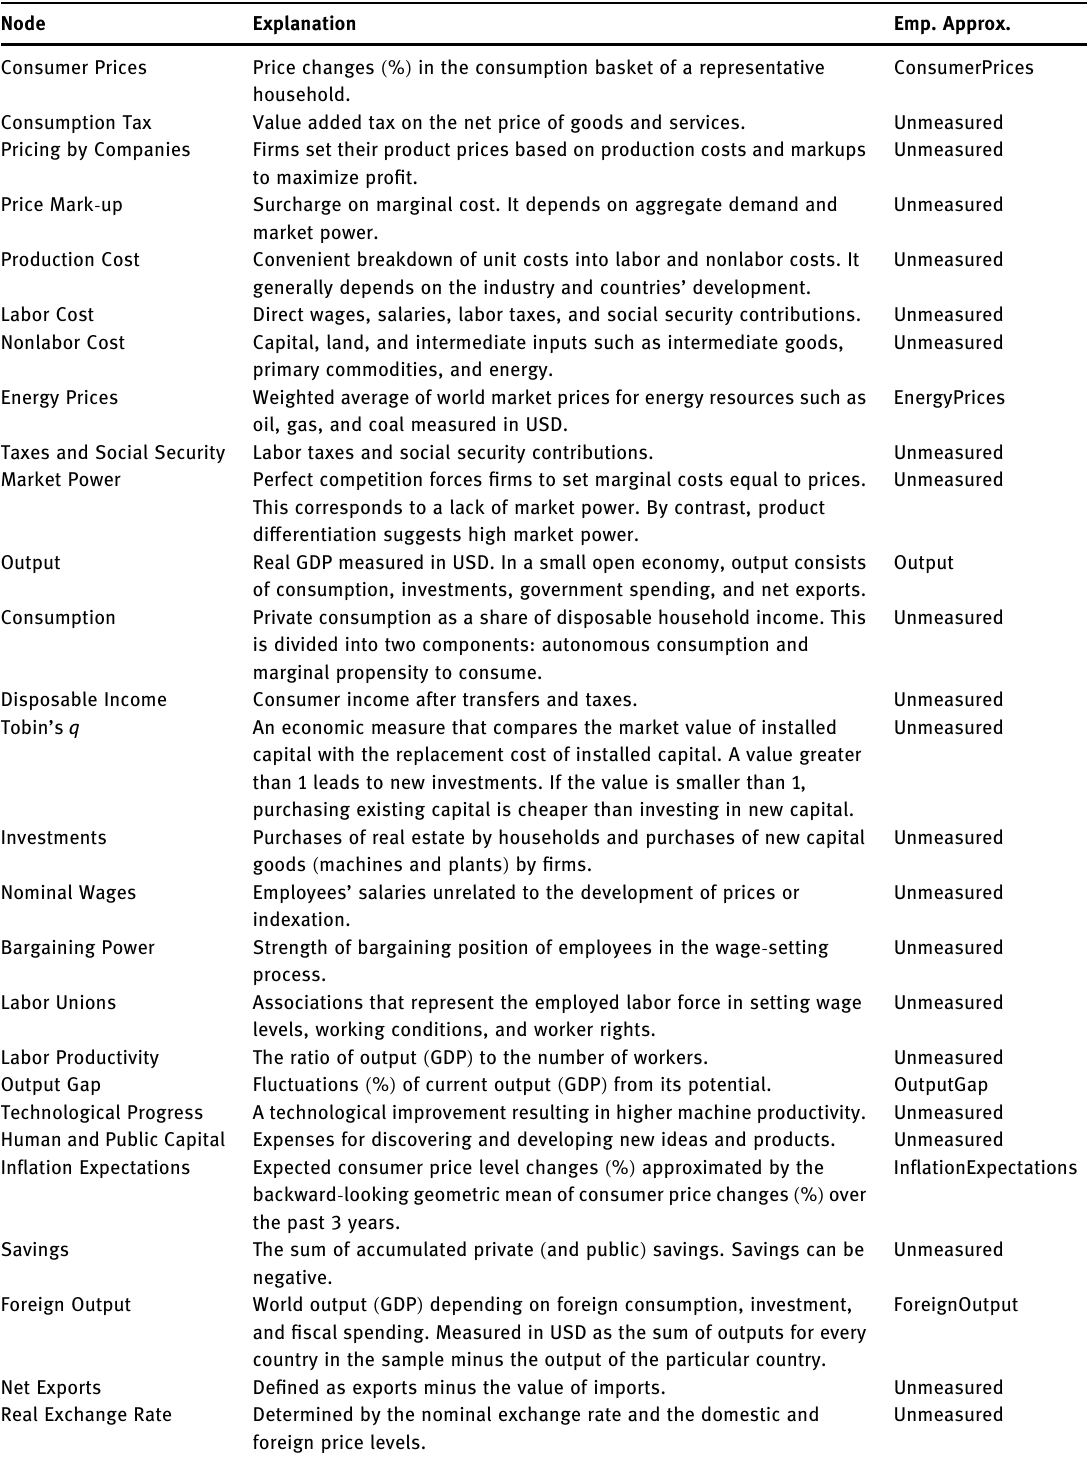
Table 2: Explanation and de fi nition of the variables shown in the causal model